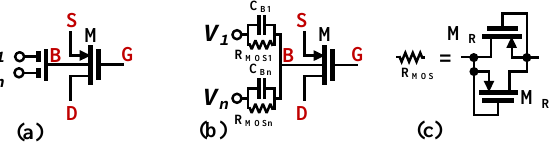
Figure 3. Bulk-driven MI-MOST: ( a ) symbol, ( b ) its realization, and ( c ) realization of RMOS. The low-frequency open-loop voltage gain of the DDCC, from one differential input,